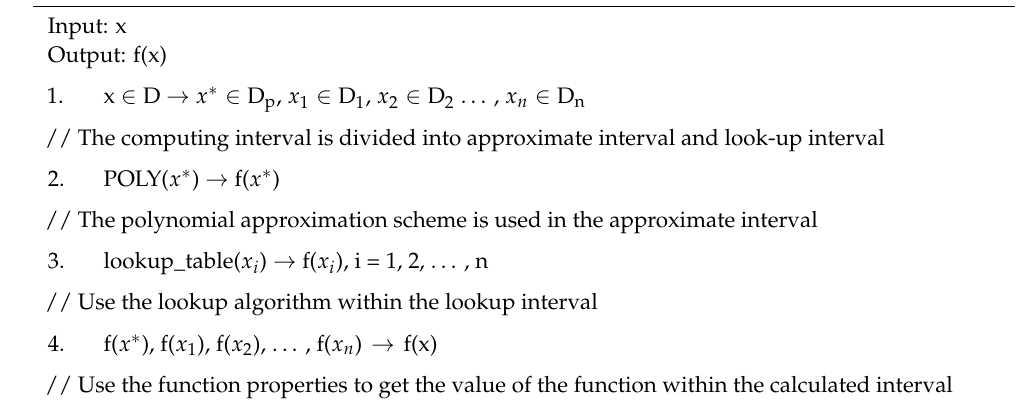
Algorithm 2. Interval partition-polynomial approximation-look-up